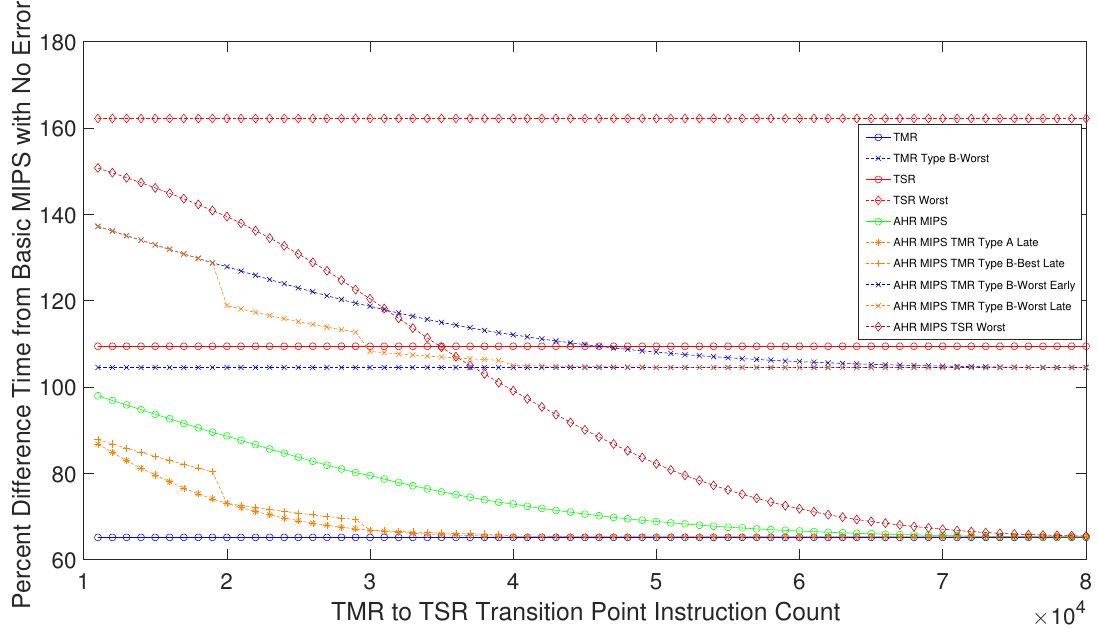
Figure 17. AHR MIPS TMR to TSR transition varying from 11,000 to 80,000 instructions: energy vs. time to complete.